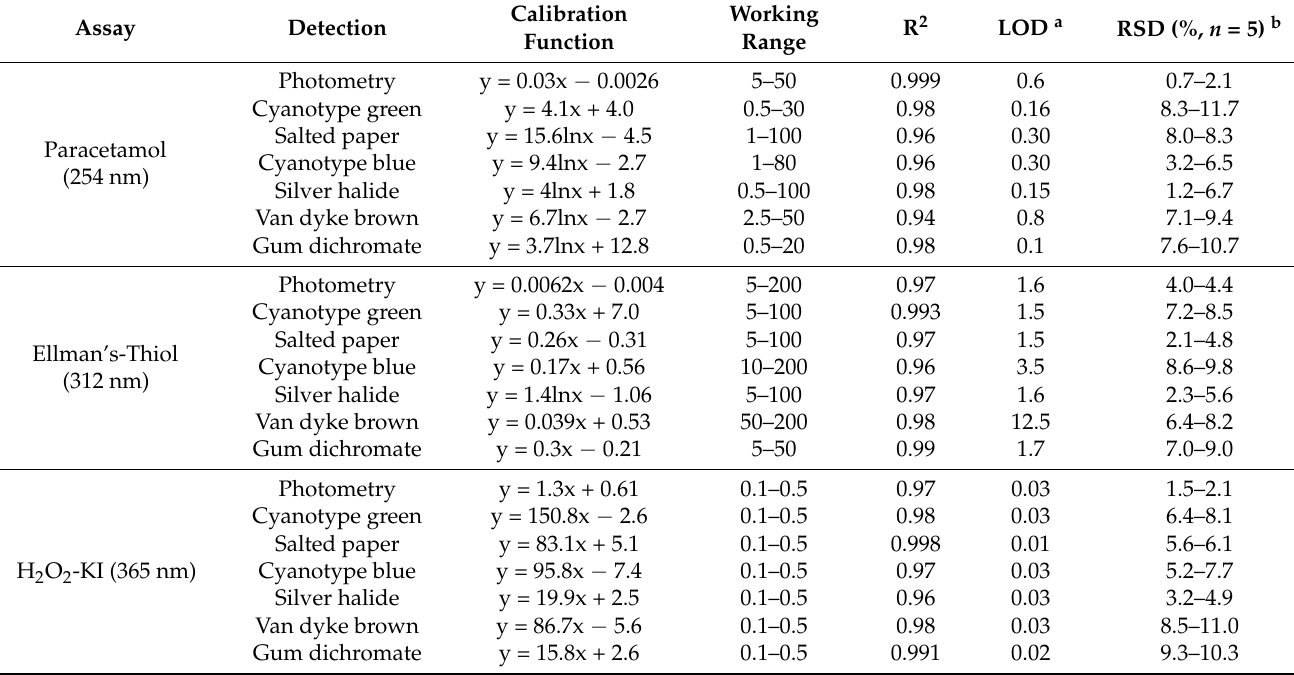
Table 2. Analytical figures of merit of photometry and photography-based photometry for the determination of paracetamol, thiols, and hydrogen